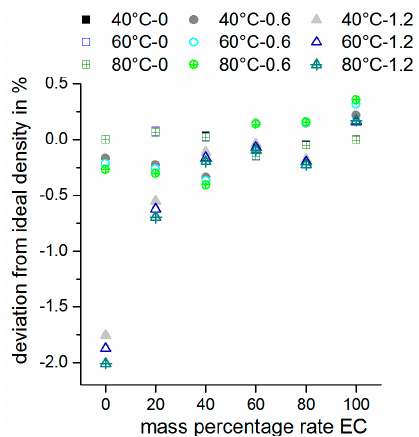
Figure 4. Density deviation from ideal behavior with Li-TFSA concentrations of 0 mol·kg − 1 (square), 0.6 mol·kg − 1 (spherical) and 1.2 mol·kg − 1 (triangle). Mass percentage rate EC is referred to EMIM-TFSA/EC mixture ratio.